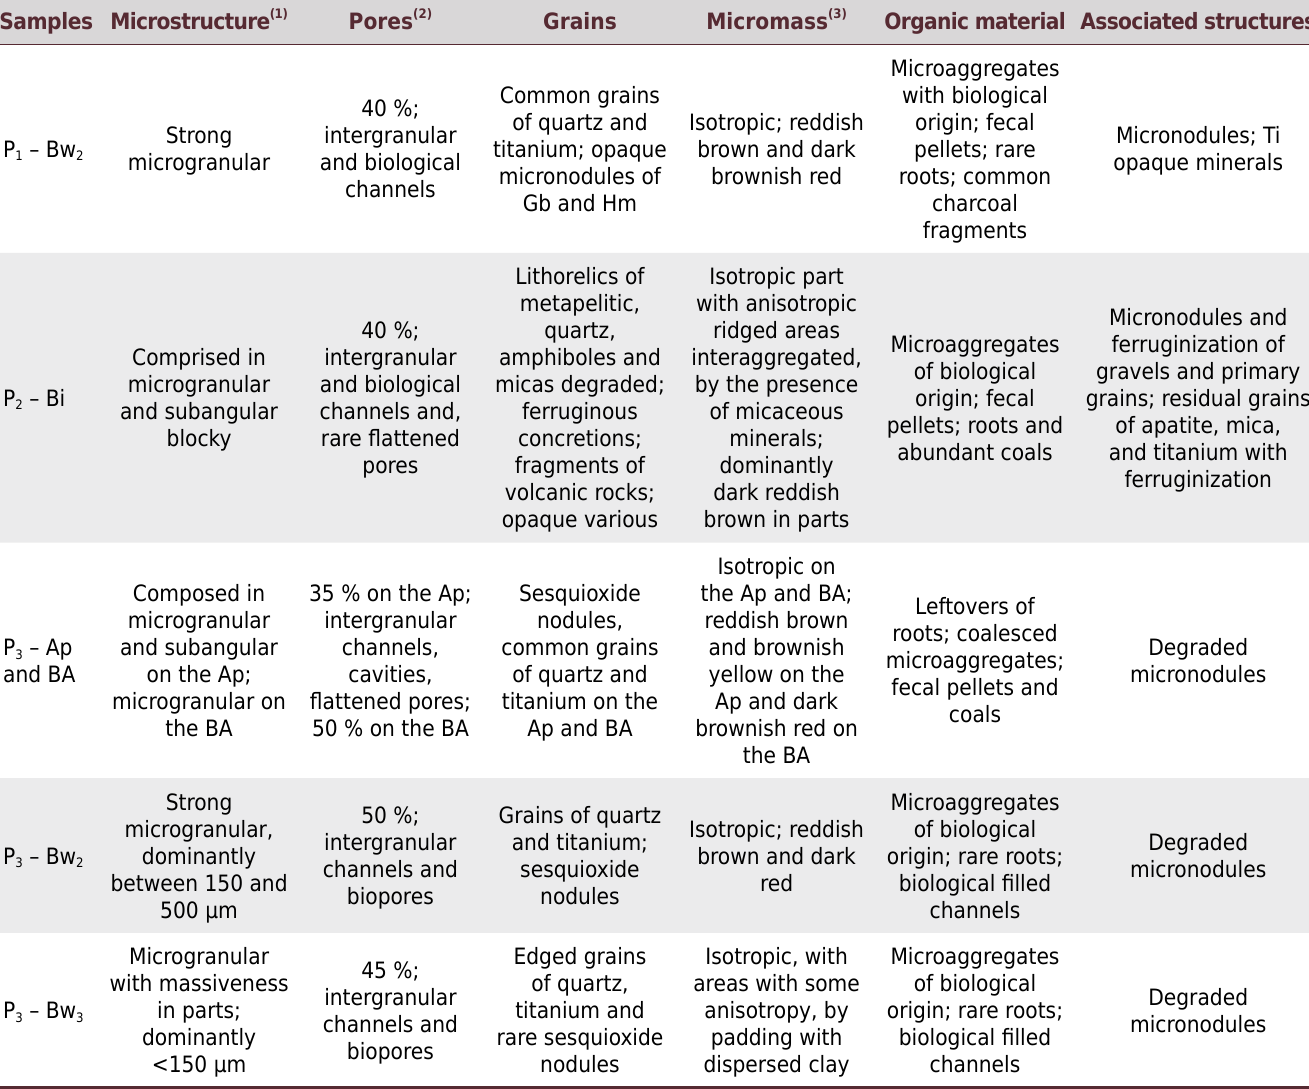
Table 2. Micropedological features of the selected horizons of soils in the Serra do Salitre topolithosequence Samples Microstructure